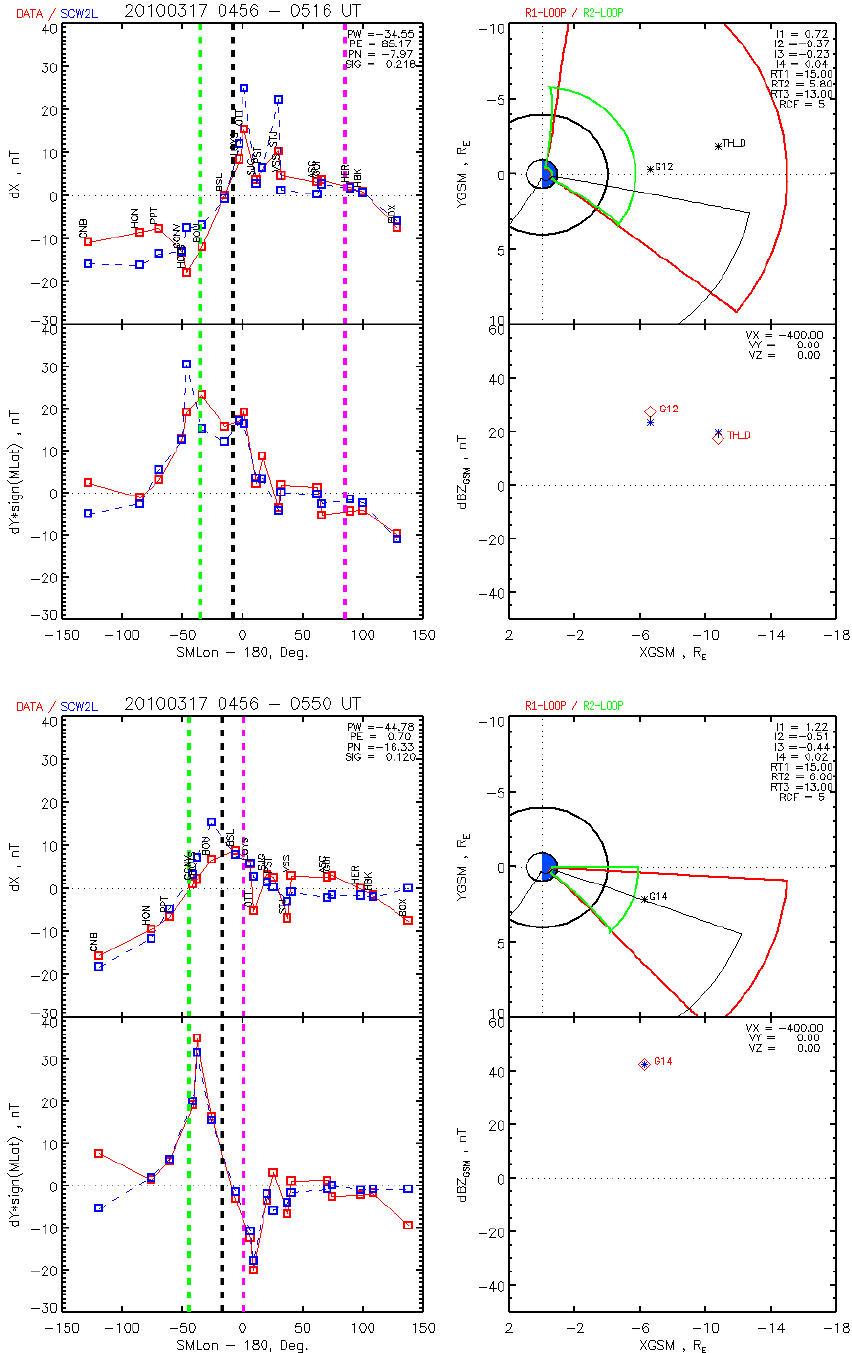
Figure 6. Inversion results for two dipolarization peaks at 05:13UT (activation no. 1, top) and 05:50UT (activation no. 2, bottom). The left panels show observed (red) and predicted (blue) ground (cid:49)X and (cid:49)Y variation amplitudes; I1, I2, I3, and I4 indicate R1, R2, DRP, and ring current intensities, repsectively. The right bottom panel shows the same for spacecraft (cid:49)B Z data. The upper right panel illustrates the SCW2L configuration projected onto the X 0 Y